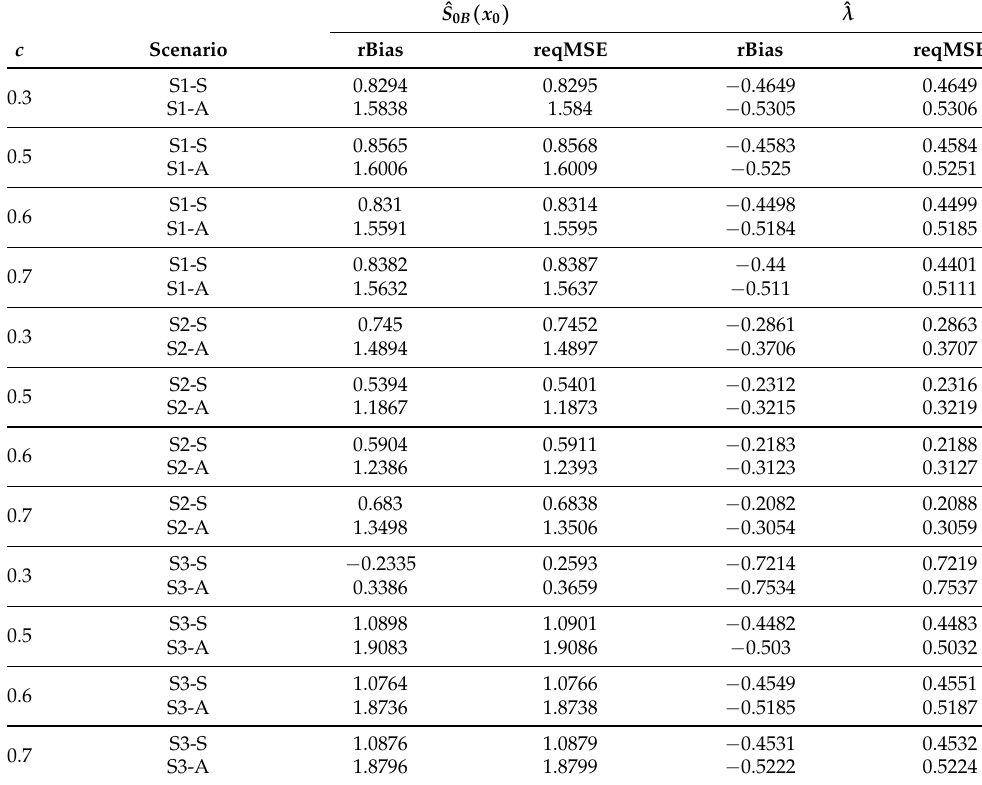
( 0.8 ) and ˆ λ for n = 50. 0